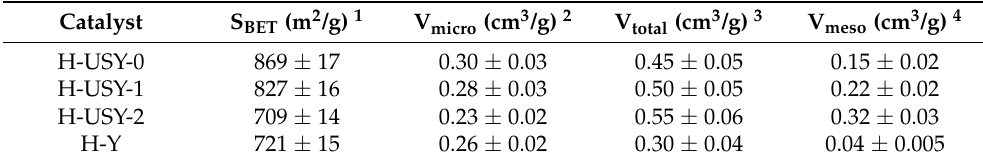
Table 1. BET surface area, micropore, total pore, and mesopore volume obtained from N 2 isotherm shown in Figure Figure 2. ( a ) N 2 adsorption-desorption isotherm at 77 K. ( b ) The pore size distribution derived from the NLDFT method applied to the nitrogen adsorption isotherms.